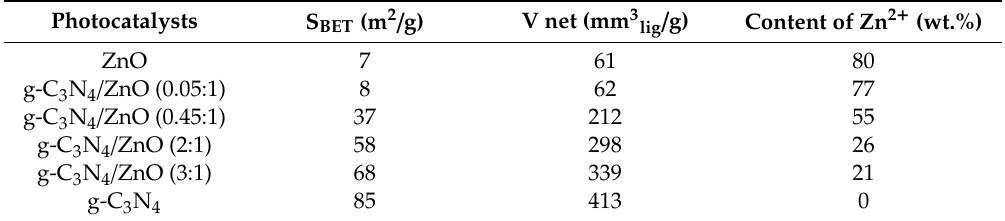
Table 1. Structural and microstructural properties and content of ZnO ZnO, g-C 3 N 4 , and g-C 3 N 4 / ZnO. Photocatalysts